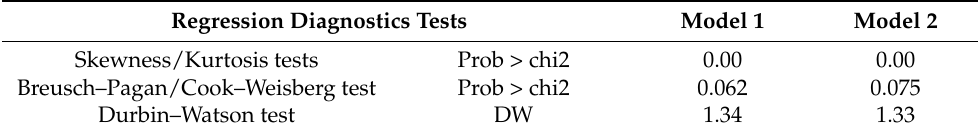
Table 4. Regression diagnostics